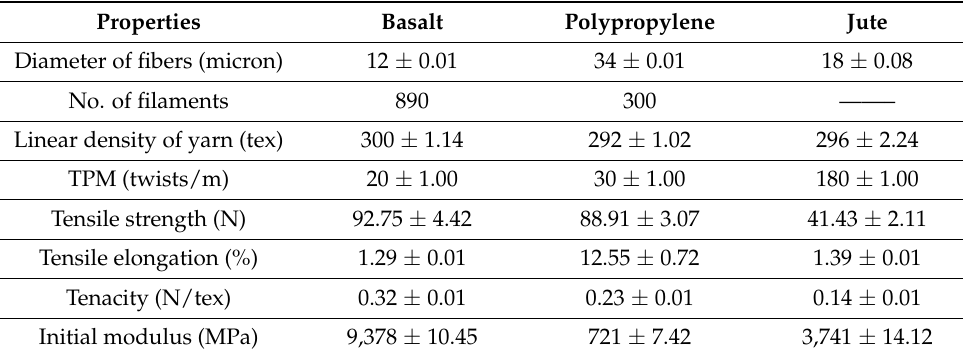
Table 1. The properties of the fibers and yarns used.